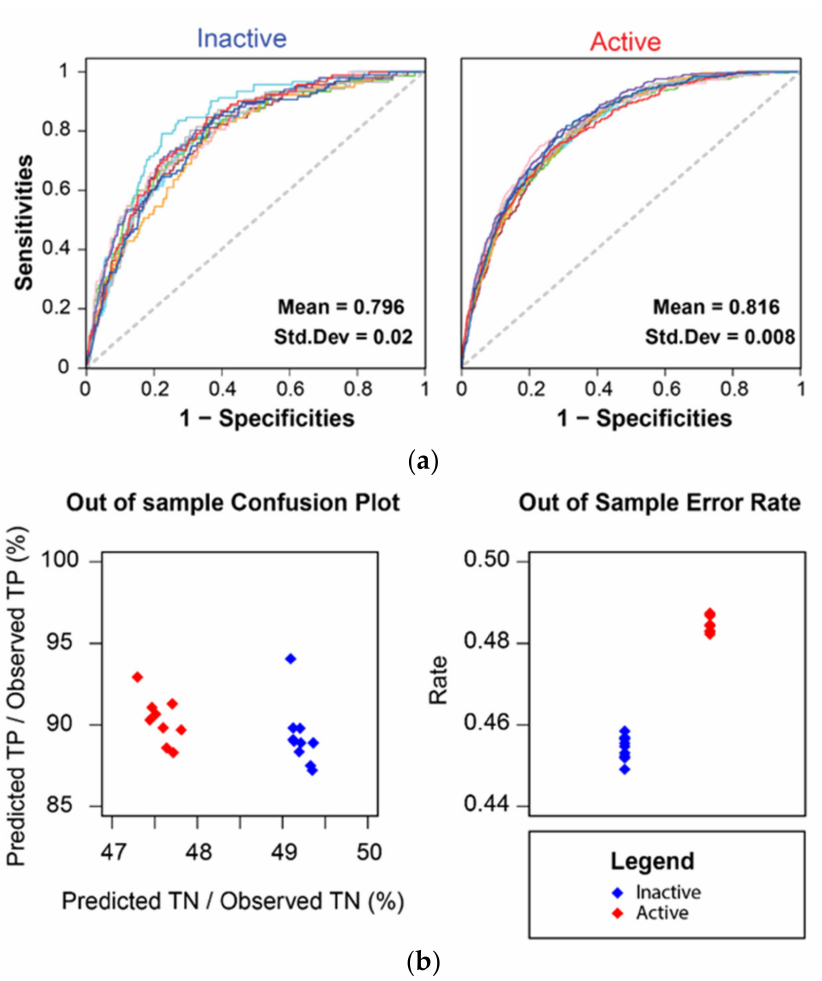
Figure 5. ( a ) ROC curves and their AUCs for ten cross-validations for the inactive ( left ) and active ( right ) landslide models. ( b ) Confusion plot ( left ) constructed via the percentage of Observed TP and fitted TP against the percentage of Observed TN and fitted TN (for each landslide type), and error rates ( right ), both have been obtained from a tenfold